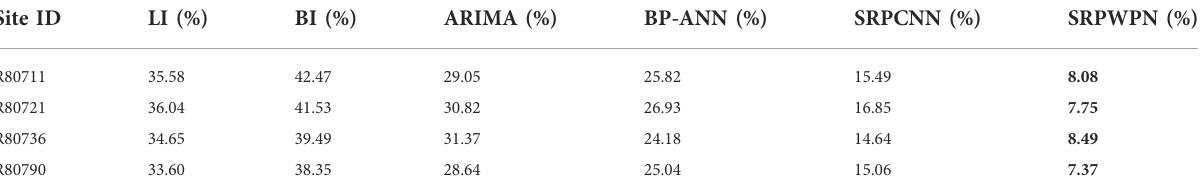
TABLE 3 Experimental results of different methods on TLHB.